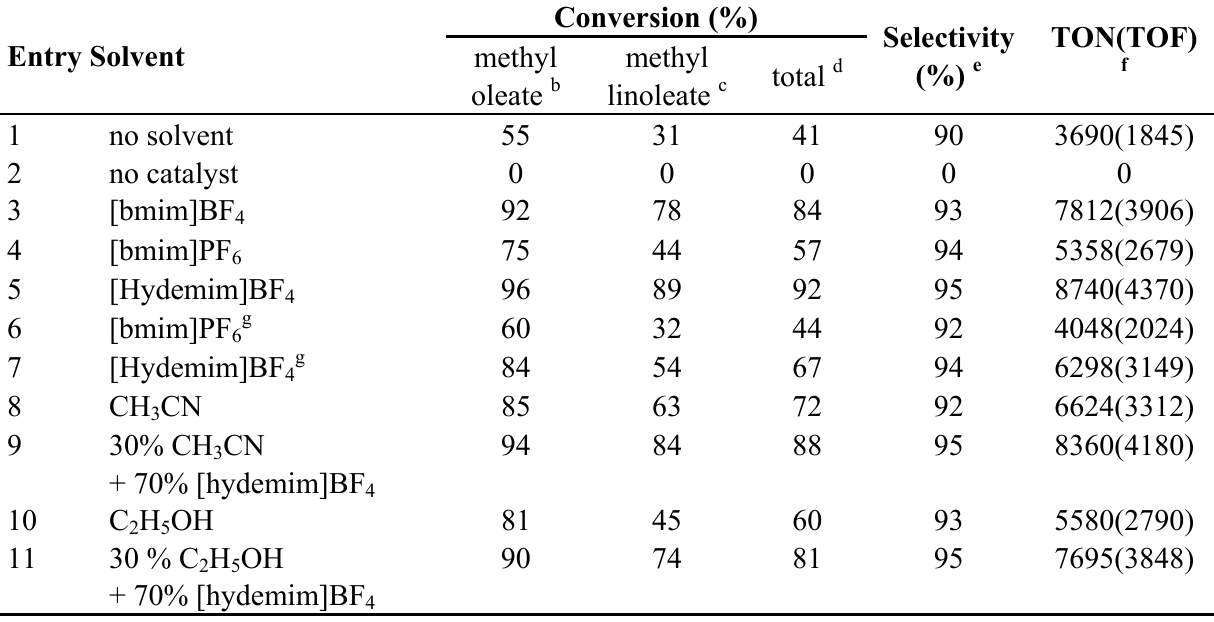
Table 1. Epoxidation of methyl oleate and methyl linoleate with hydrogen peroxide ) ·2QOH] (QOH = 8-quinilinol) in ILs. catalyzed by [MoO(O 2 2